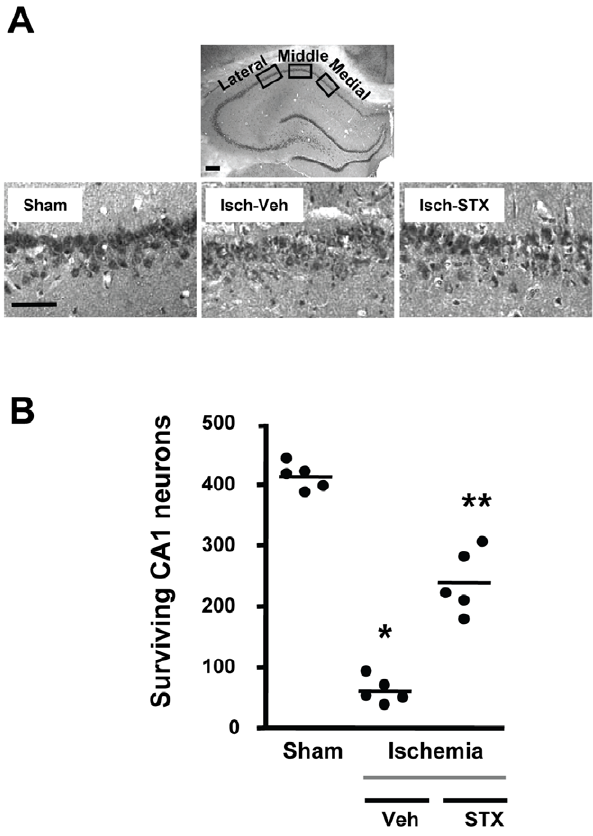
Figure 3. STX affords neuroprotection in short-term OVX, middle-aged rats when administered after ischemia. Middle- aged female rats were subjected to sham surgery or global ischemia (Isch) 1 week after OVX. Panel A shows representative photomicro- graphs of hippocampal neurons in the dorsal CA1 region 7 days after sham surgery or global ischemia in animals injected ICV immediately after reperfusion with either vehicle (DMSO) or STX (50 m g). Scale bars: low magnification, 400 m m; higher magnification, 60 m m. Panel B: Quantification of living pyramidal neurons was performed in the CA1 region of the hippocampus 7 days after ischemia. Neurons were counted in 3 sectors (lateral, middle and medial) of the dorsal hippocampus. ANOVA followed by Newman Keuls, * p , 0.001 versus sham, ** p , 0.001 versus ischemia/vehicle.